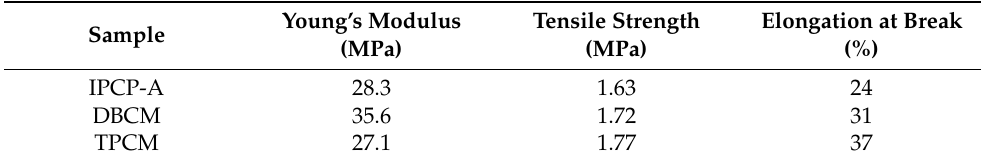
Table 4. Mechanical properties of IPCP-A, DBCM, and TPCM.